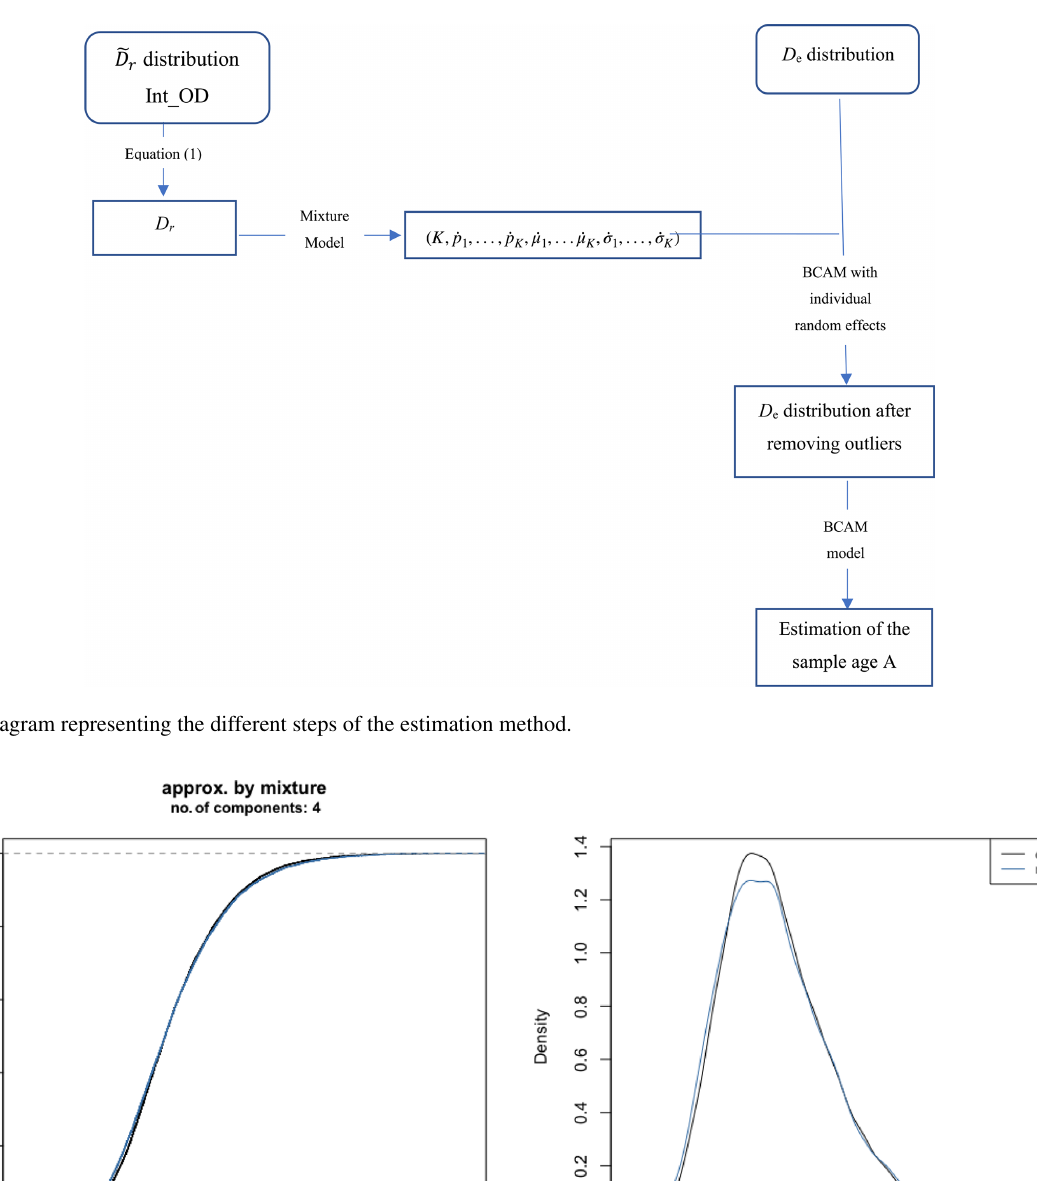
plot. This last figure compares the cumulative D e distribu- tions (with or without the identified outliers) with the mod- elled D e distribution ( A × D r ). We provide a simple example with R code in the